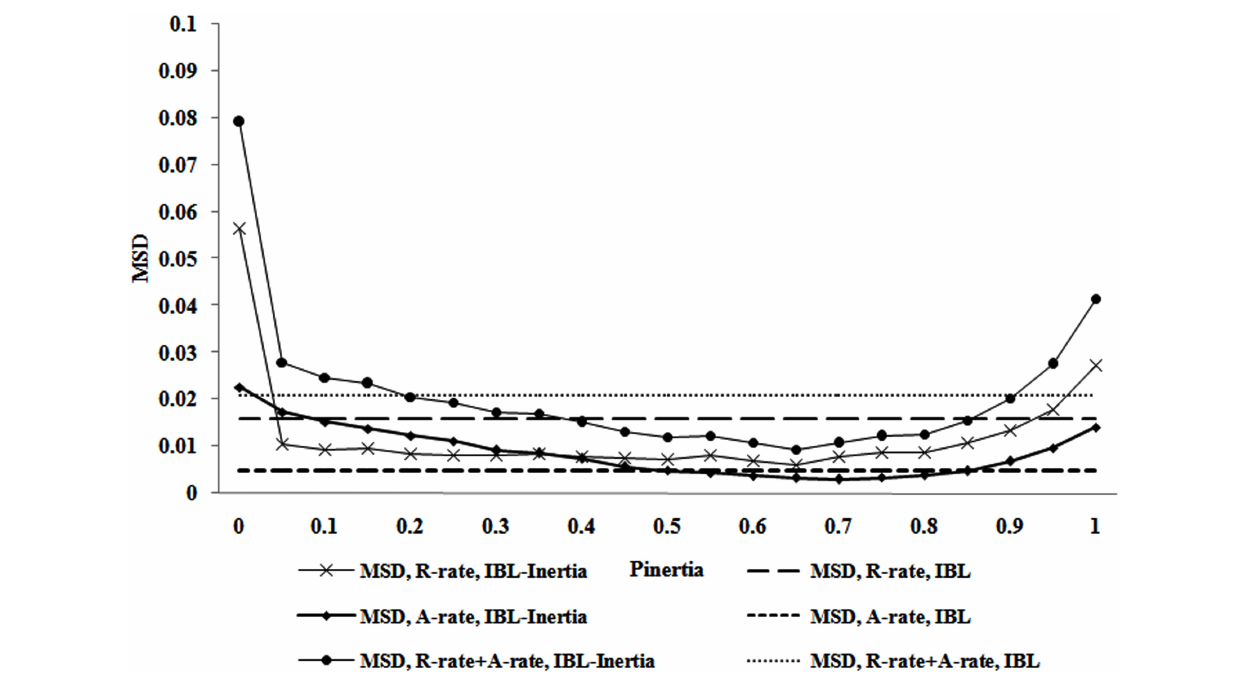
model are also plotted as dotted lines for comparison). The IBL-Inertia model used the calibrated parameters for d and s parameters (i.e., d = 6.41 and s =